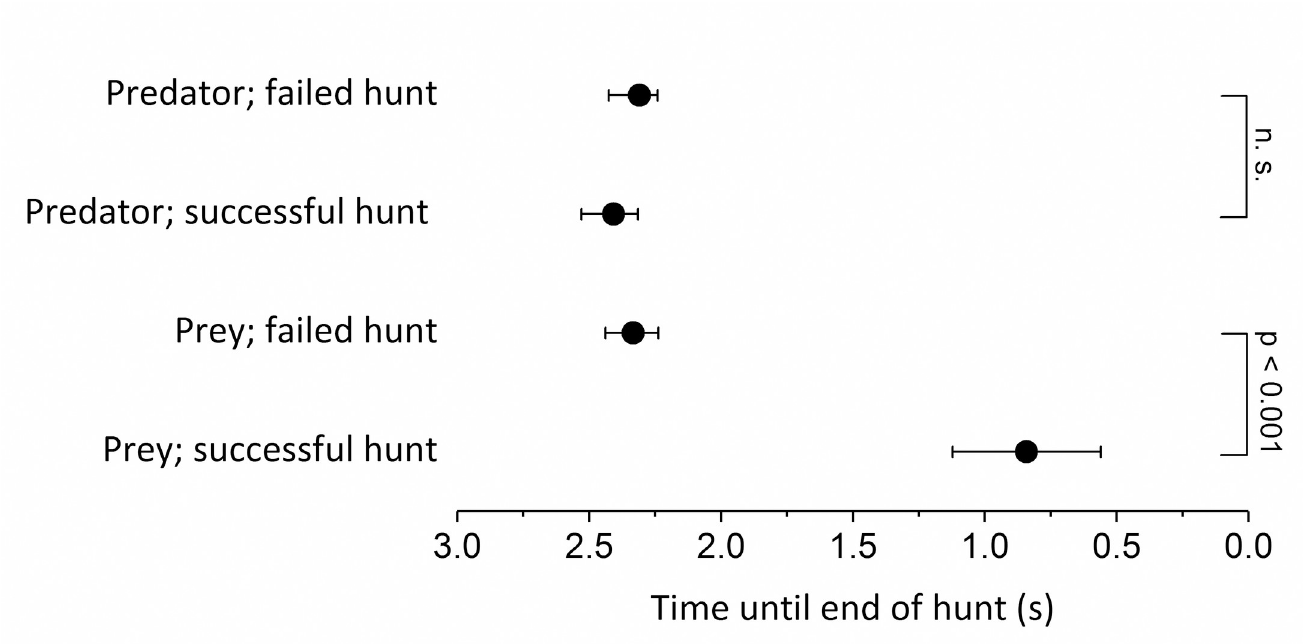
Fig 4. Breakpoint analysis. To identify changes in swimming speed in successful and unsuccessful whitefish hunts, the first breakpoint was selected using segmented linear regression analysis of the three second period before the biting event or attempt.